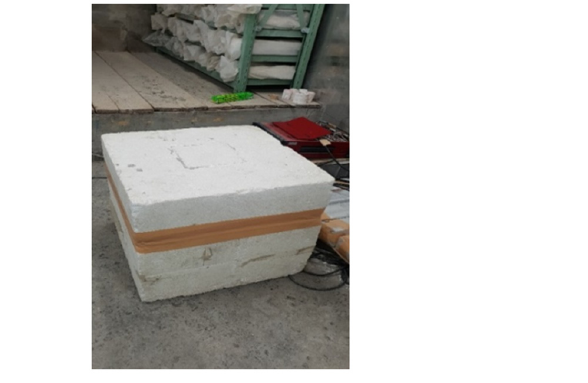
Figure 4. Concreteaftercastingfortemperatureriseinconcretemeasurementinthesemiadiabaticcondition. Infrastructures 2020 , 5 , x FOR PEER REVIEW 6 of 16 Figure 4. Concrete after casting for temperature rise in concrete measurement in the semi adiabatic condition. Figure 4. Concrete after casting for temperature rise in concrete measurement in the semi adiabatic condition.